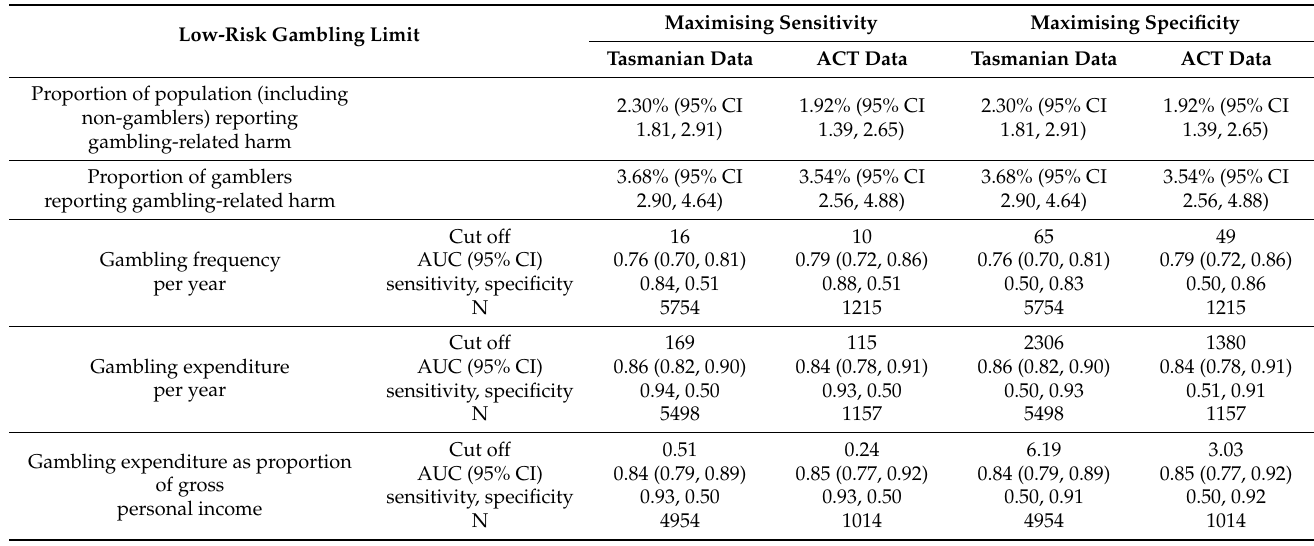
Table 6. Receiver Operating Characteristic (ROC) analyses maximizing sensitivity and specificity a,b